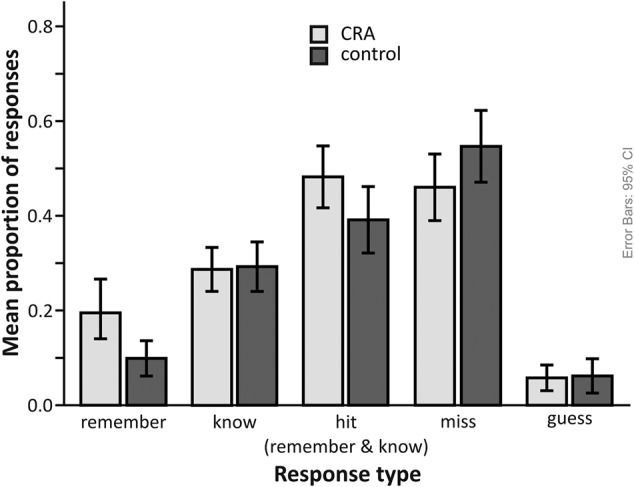
Recognition memory performance (proportion of responses) for CRA (induced insight) and control items. The data are split for response category (remember, know, guess, miss). To provide an overview, all responses considered hits, i.e., correctly recognizing items as old, are represented in the “hit (remember and know responses)” bar.